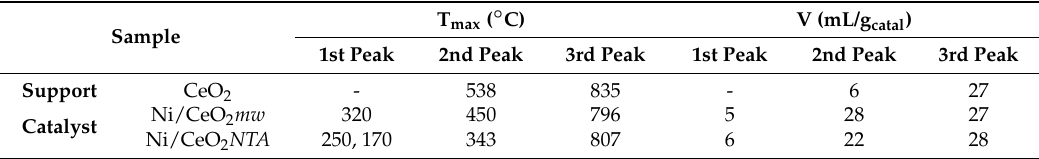
Figure 7. Temperature programmed reduction (TPR) profiles of the two catalysts and the corresponding support CeO 2 . Table 2. T max and H 2 consumption volumes (V) of the TPR peaks that were obtained for the CeO 2 supports and Ni